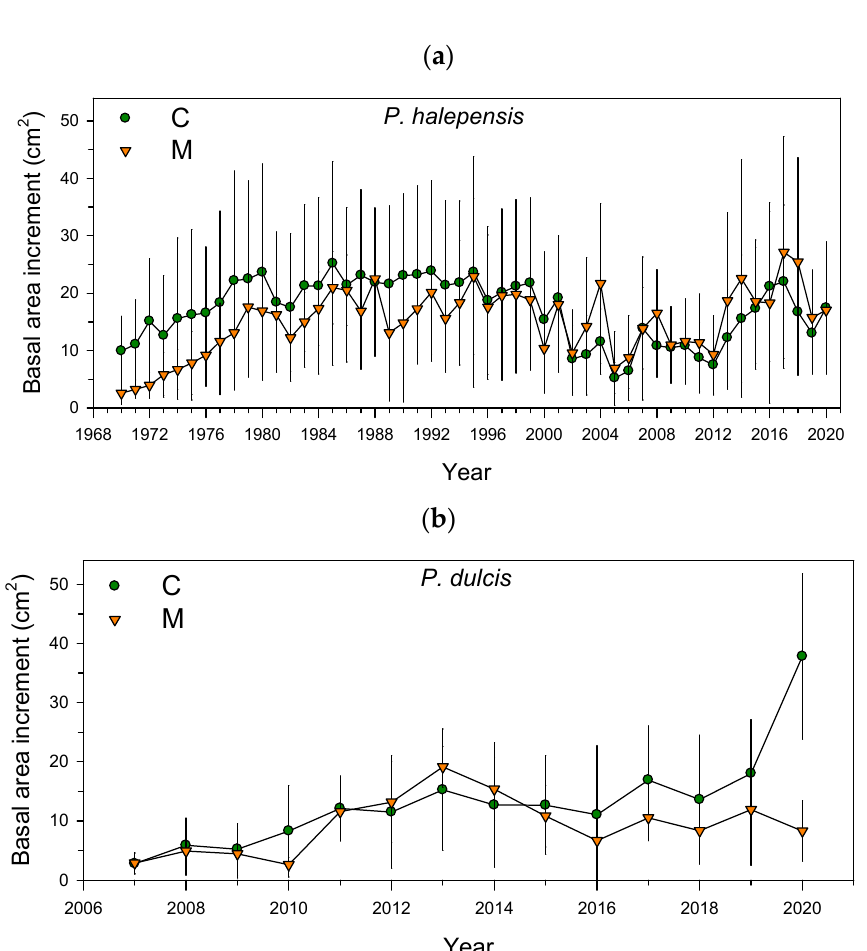
Figure 3. Tree growth (basal area increment) in control (C, green circles) and manure-applied (M, orange triangles) trees of the two study species: ( a ) P. halepensis ; ( b ) P dulcis . Values are means ± SD.